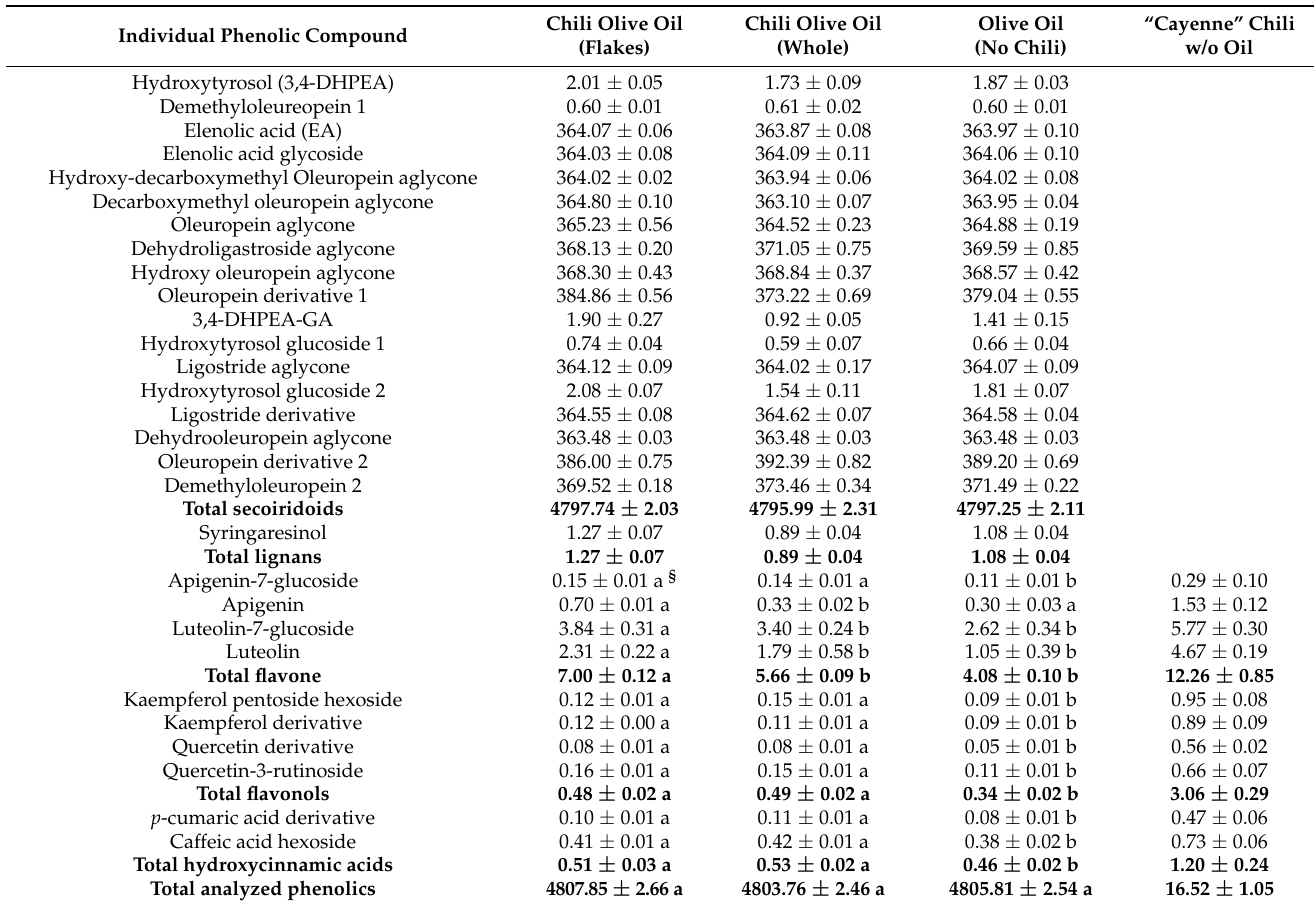
Table 3. Individual olive oil phenolic contents (mean ± SE) in mg/100 mL. Individual phenolics were compared among pure chili olive oil, chili olive oil with flakes, and chili olive oil with whole chilies. The “Cayenne” chili phenolic content is only for